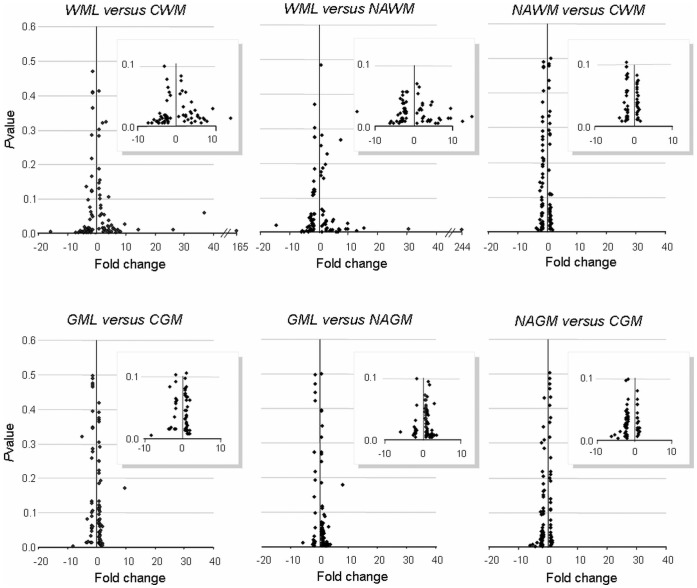
Differential gene expression of PTP family members in MS white and gray matter lesions.Data were expressed as a ratio of % expression vs HKGs between two samples (fold change) and represented in a volcano plot diagram (y: Pvalue; x: fold change). An intensive modulation is characterized by spread values close to the x axis (magnification in square). NAWM, Normal-appearing White Matter; NAGM, Normal-appearing Grey Matter; WML, White Matter Lesion; GML, Gray Matter Lesion; CGM, Control gray Matter; CWM, Control White Matter. Major changes occur in lesioned areas and are more intensive in white matter.